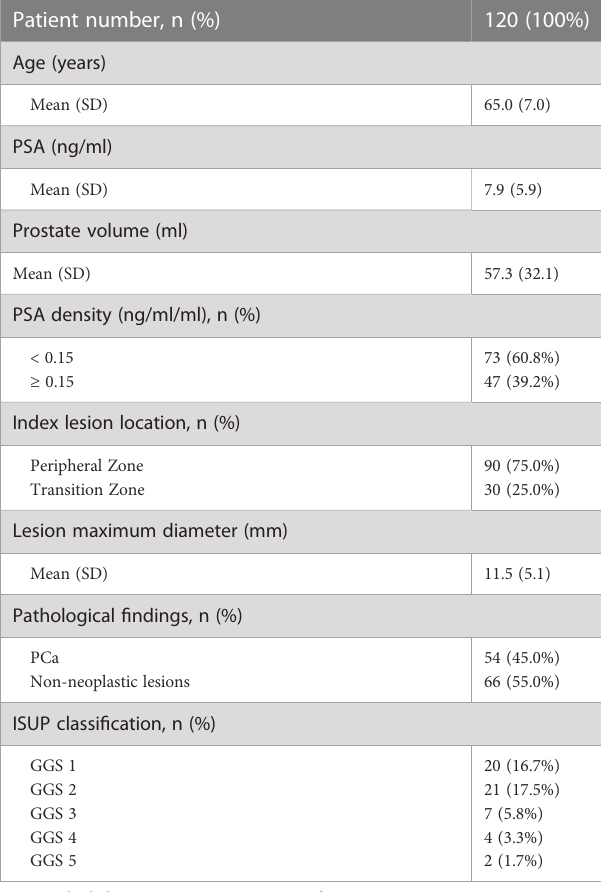
TABLE 1 Overall demographic and clinic characteristics of the patient population.